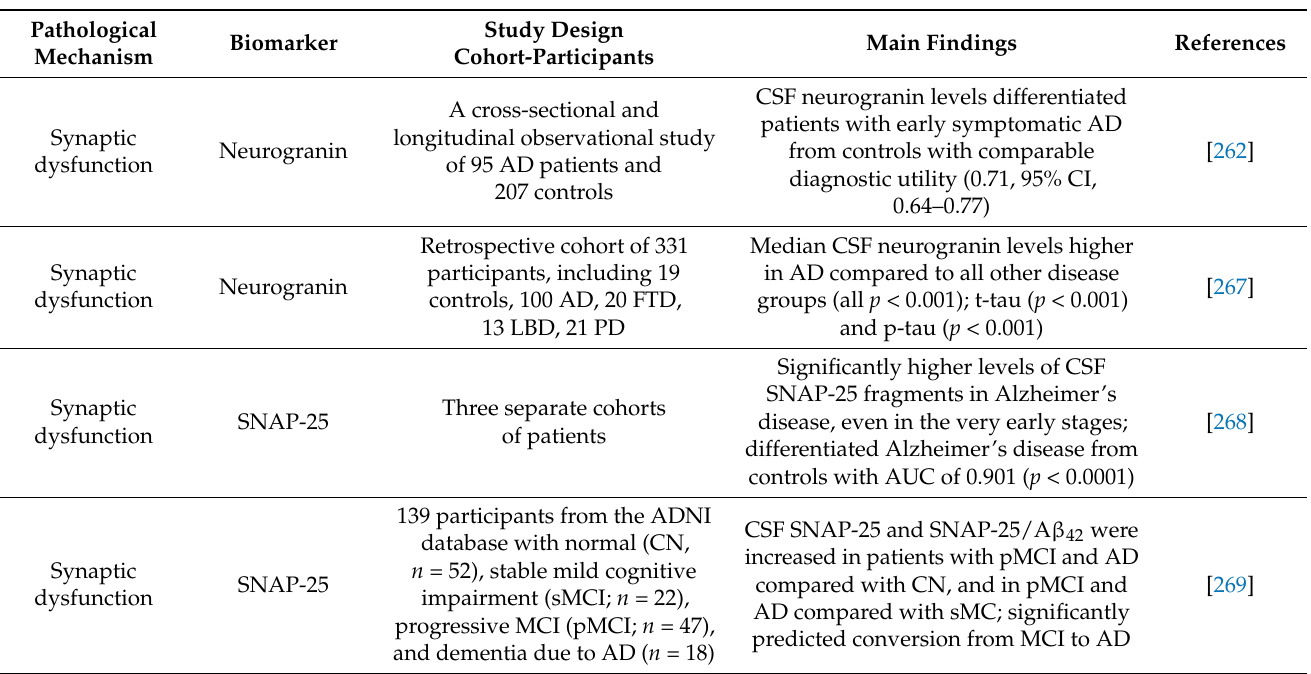
Table 3. Pathological mechanisms (synaptic dysfunction, neuronal injury) and associated biomarkers of Alzheimer’s disease and the findings of related